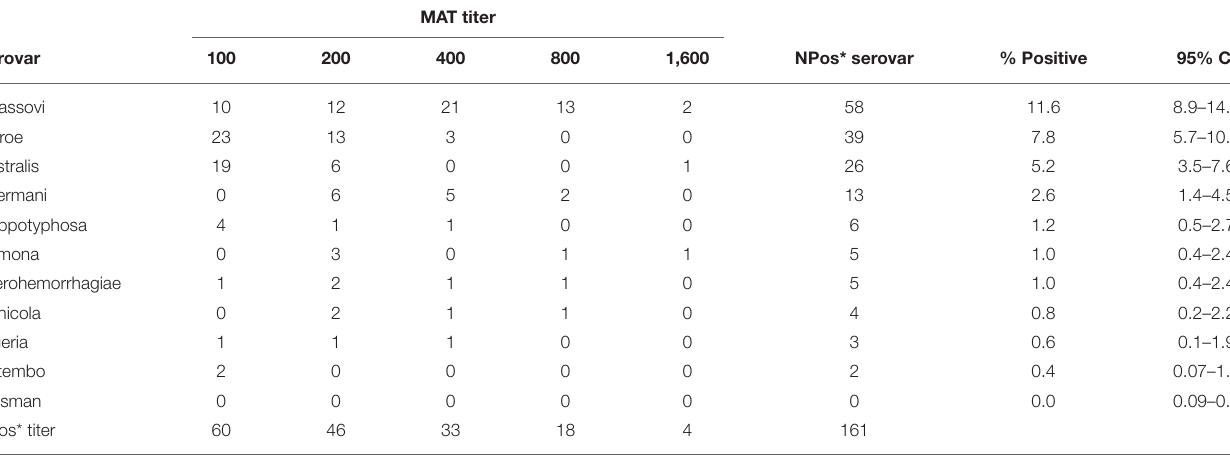
TABLE 3 | Prevalence and levels (titers) of serovar-specific anti- Leptospira antibodies measured by the microscopic agglutination test (MAT) among cattle slaughtered at major Ugandan abattoirs ( N = 500). MAT